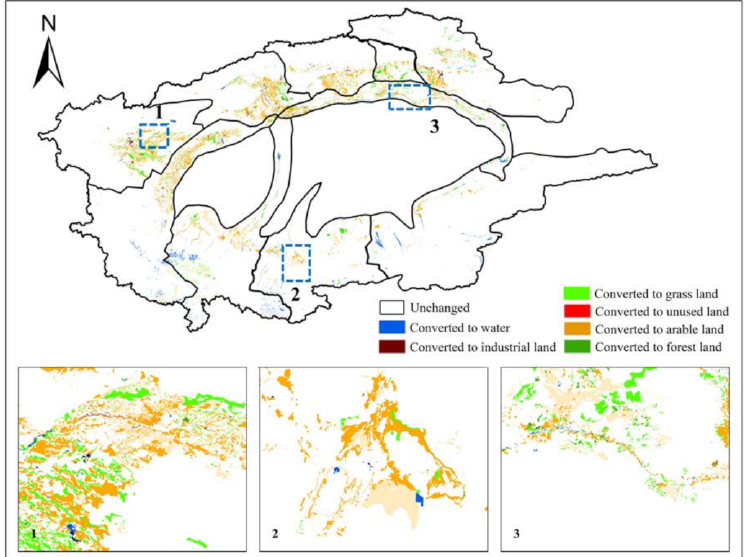
Figure 4. Land-use transfer map of the Tarim River Basin from 1990 to 2015. The lower maps show the local changes in ( 1 ) the Weigan River Basin, ( 2 ) the Keriya River Basin, and ( 3 ) the main stream of the Tarim River.